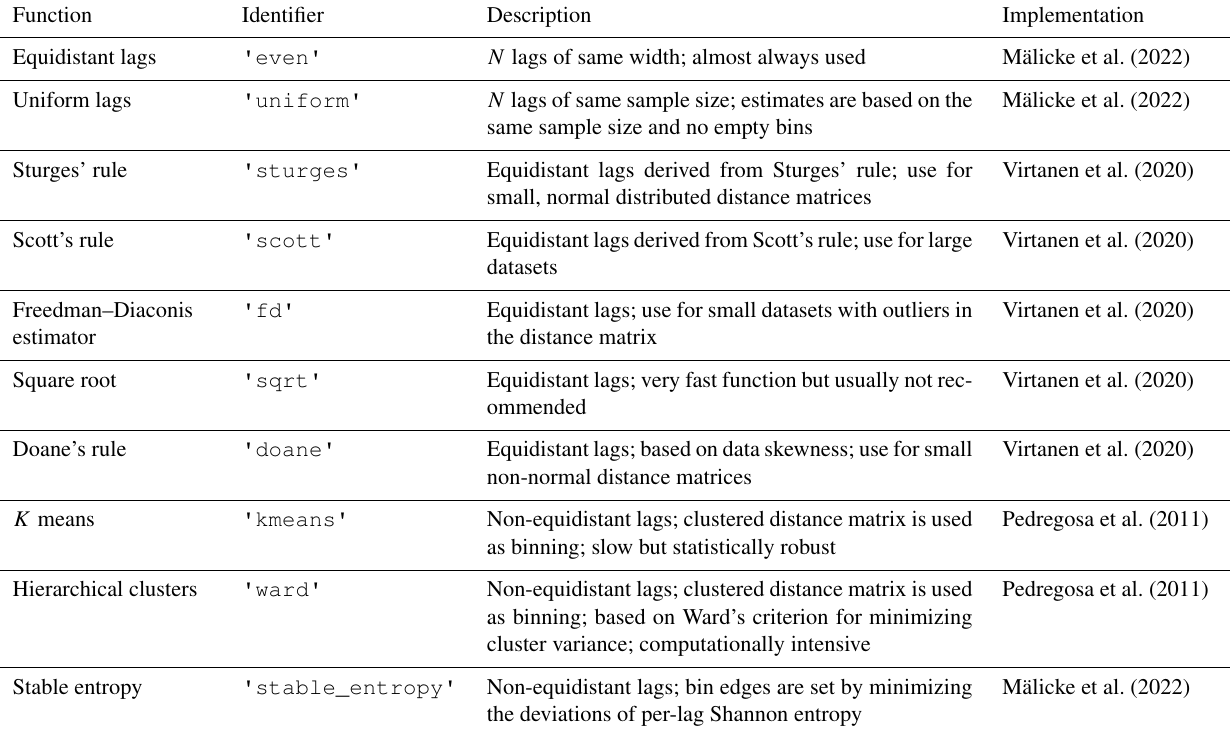
Table 3. Overview of all lag class binning methods implemented in